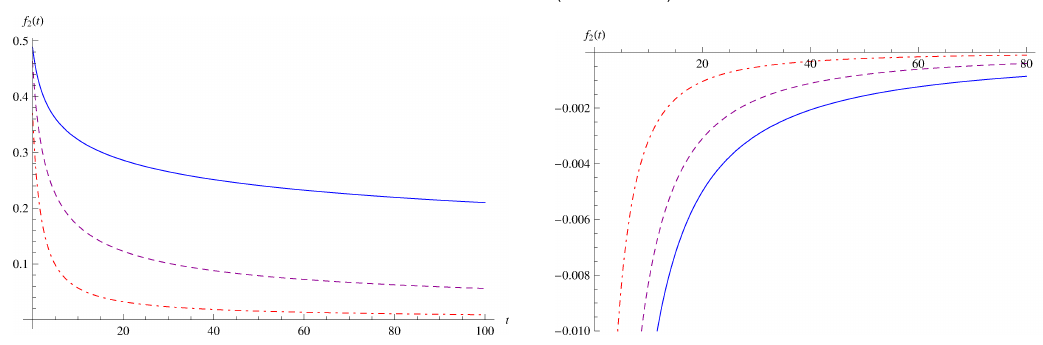
Fig. 4. The curves of f 2 .t/ for b D c D 1 and for ˛ D 0:25 (solid line), ˛ D 0:5 (dash line) and ˛ D 0:75 (dot-dash line).